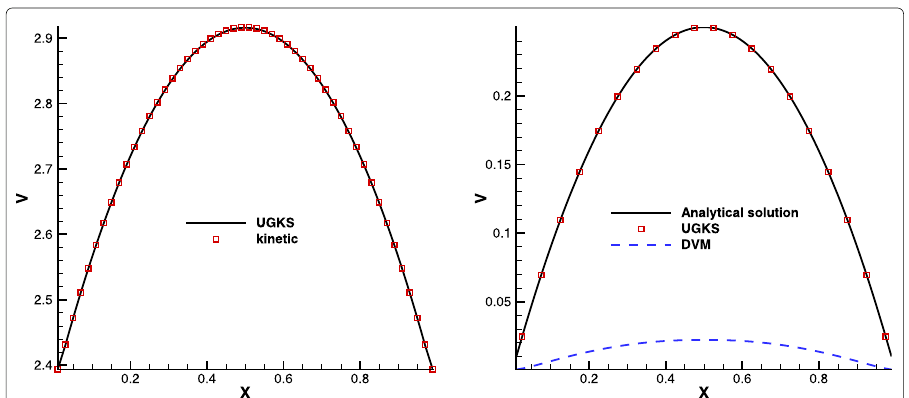
Fig. 5 The steady solution of Poiseuille flow. Symbol shows the UGKS solution, comparing to the analytical solution and traditional discrete ordinate method solution. Left figure shows the solution with Knudsen number Kn = 1.0, and right figure shows the solution with Knudsen number Kn = 1.0 × 10 − 4